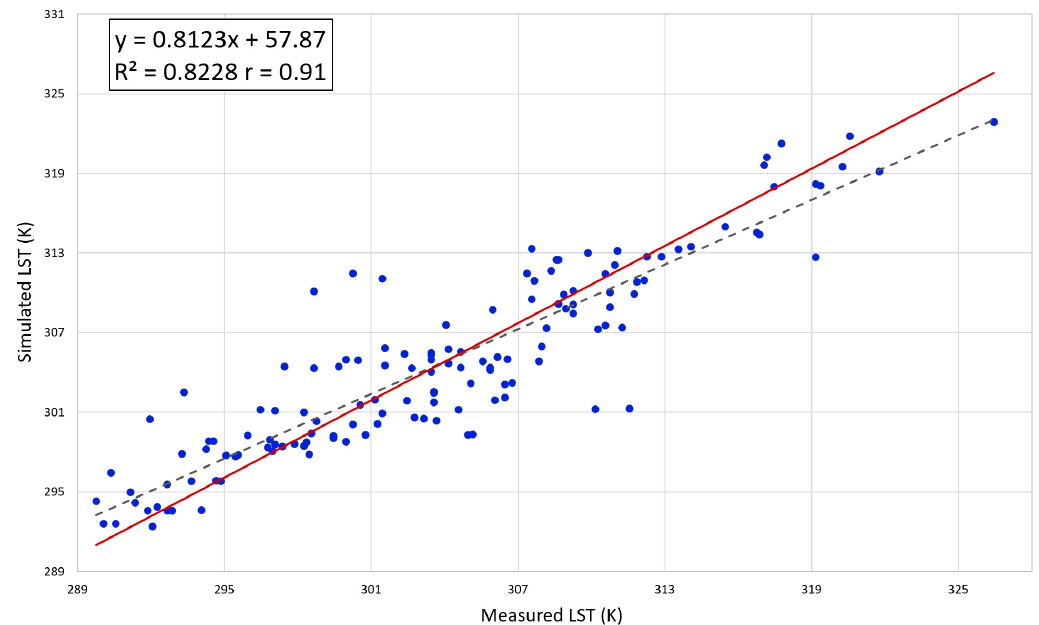
Figure 7. Scatterplot of measured and simulated LSTs in 10 selected locations in the study area on 25 June